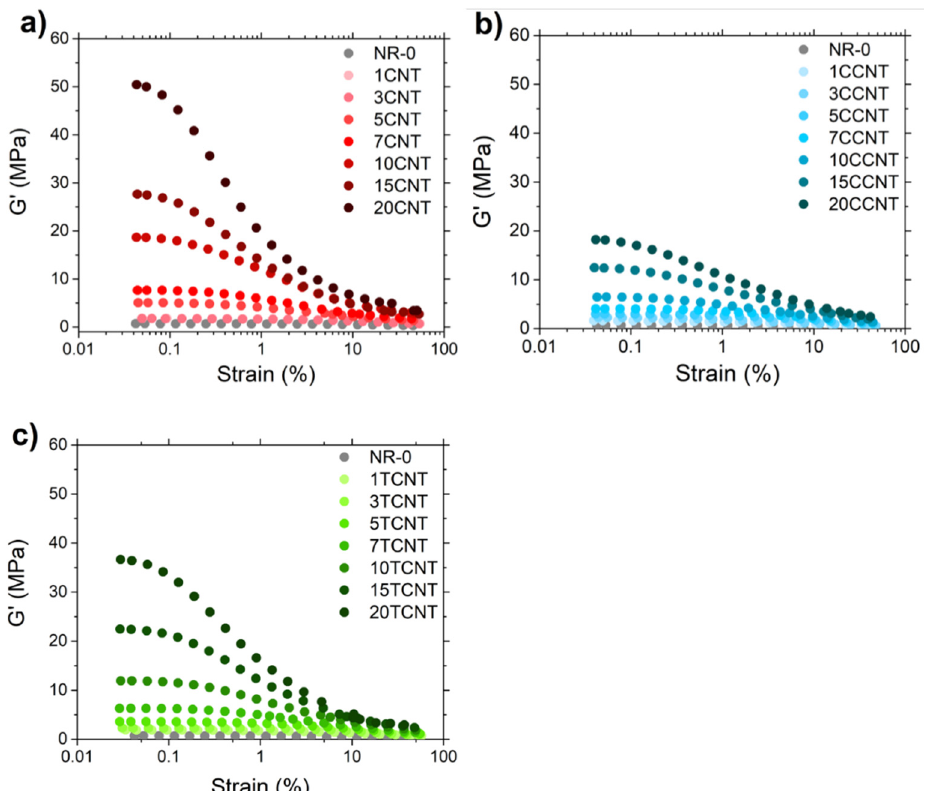
Figure 13. Strain dependence of G' for the CNT filled compounds ( a – c